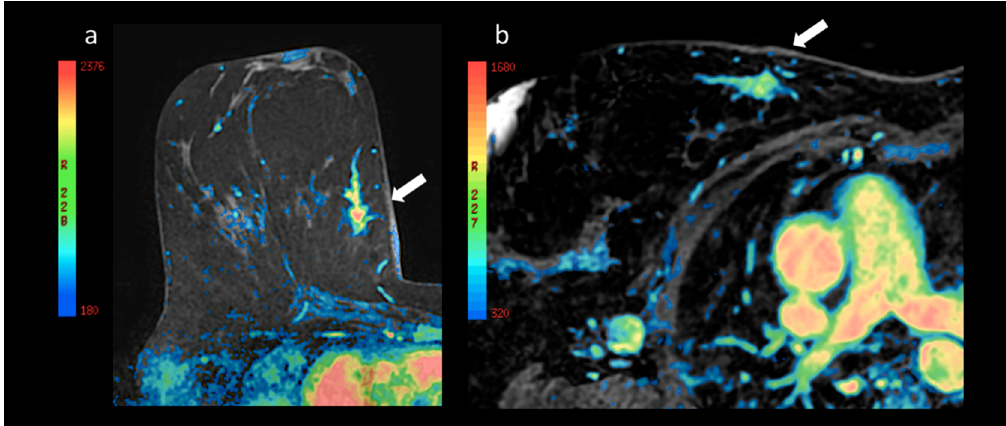
Figure 7. ( a ) Enlargement of the lesion at the confluence of the internal quadrants of the right breast with superimposition of the colorimetric map already shown above in Figure 5, and ( b ) the lesion corresponding to the ipsilateral upper internal quadrant in the prone and supine position (arrow), respectively. Note the different distribution of the colorimetric map with a prevalence of elevated maximum increase values after the administration of contrast in the prone position ( a ) as compared with the supine position ( b ).